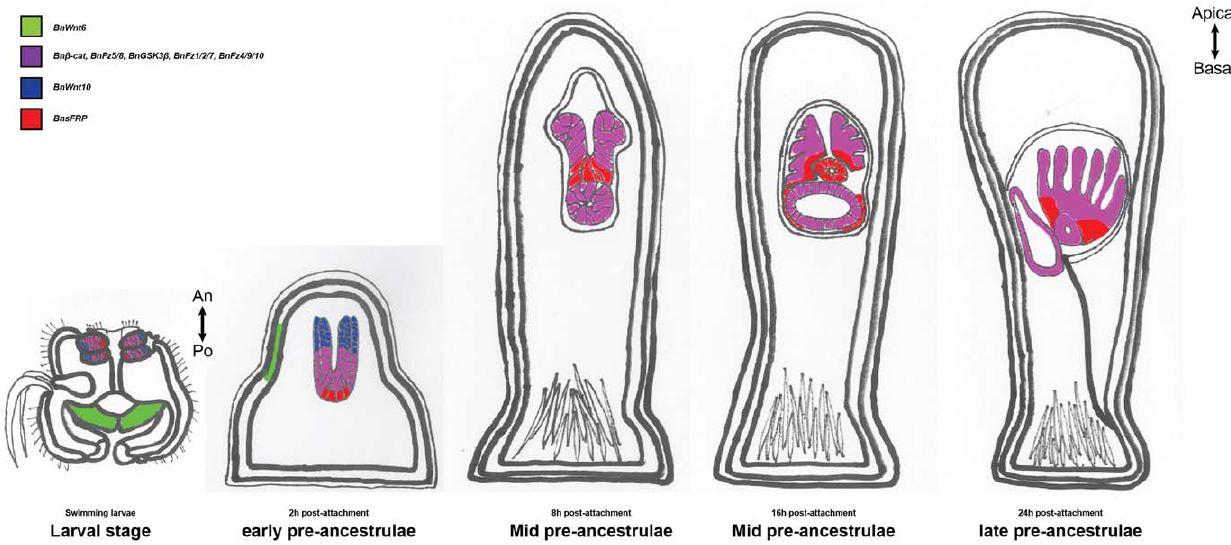
Figure 7. Overall summary of spatial gene expression patterns. Green: BnWnt6 ; Red: BnsFRP ; Blue, BnWnt10 ; Purple: BnFz4/9/10 , BnFz1/2/7 , BnGSK3 b , BnFz5/8 and Bn b cat . Note that the purple zone in the mid- and late pre-ancestrula stages did not include BnFz4/9/10 , BnFz1/2/7 , BnGSK3 b . An: anterior; Po: posterior.